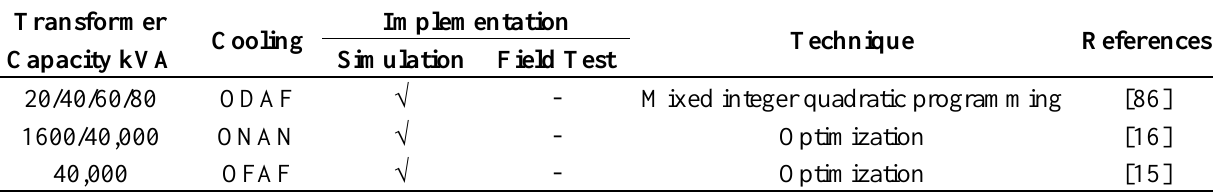
Table 2. Transformers on which the ageing is influenced by